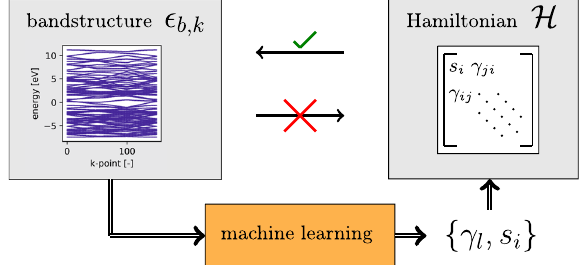
Fig. 2 Schematic of the inverse BS problem. For a given Hamiltonian, calculating a BS is trivial. By contrast, there is no constructive algorithm to obtain a Hamiltonian from a BS. Using ML, we aim to fi nd such an inverse mapping from BS data (scalar energy values ϵ b , k for each band b and k-point k ) to a minimal list of TB parameters { γ l , s i } (for each distance and onsite class l ) which describes a full TB Hamiltonian H